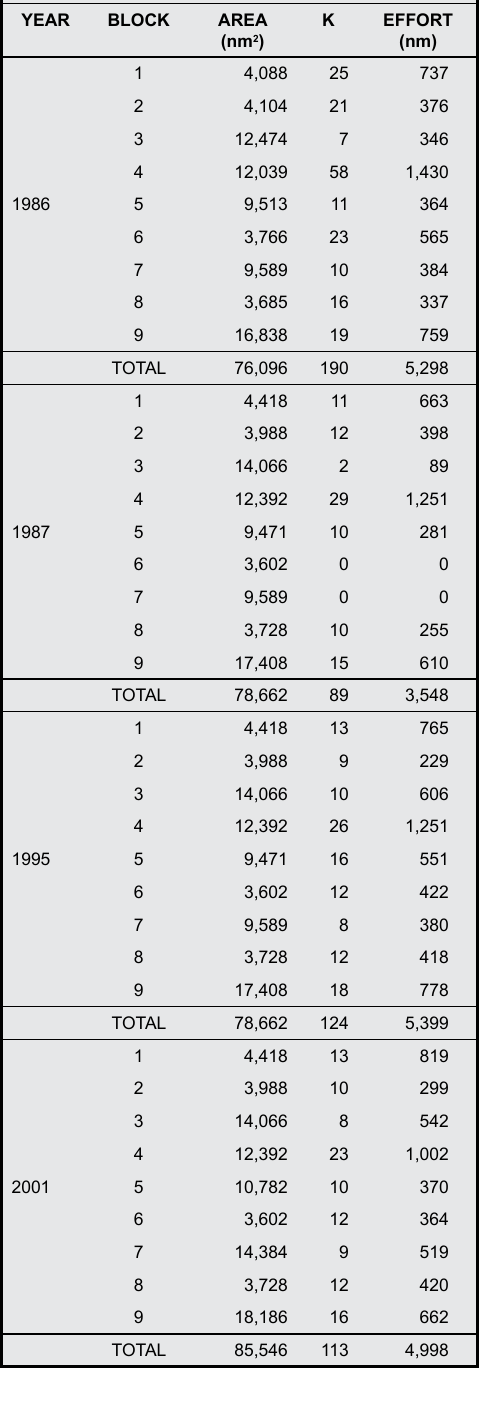
Table 1. Characteristics of aerial surveys flown in Icelandic coastal waters, 1986-2001. K – number of transect lines flown.